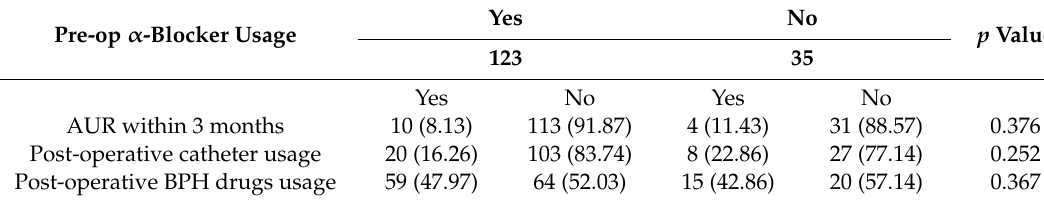
Table 5. Pre-operative (Pre-op) α -blocker usage with end points.